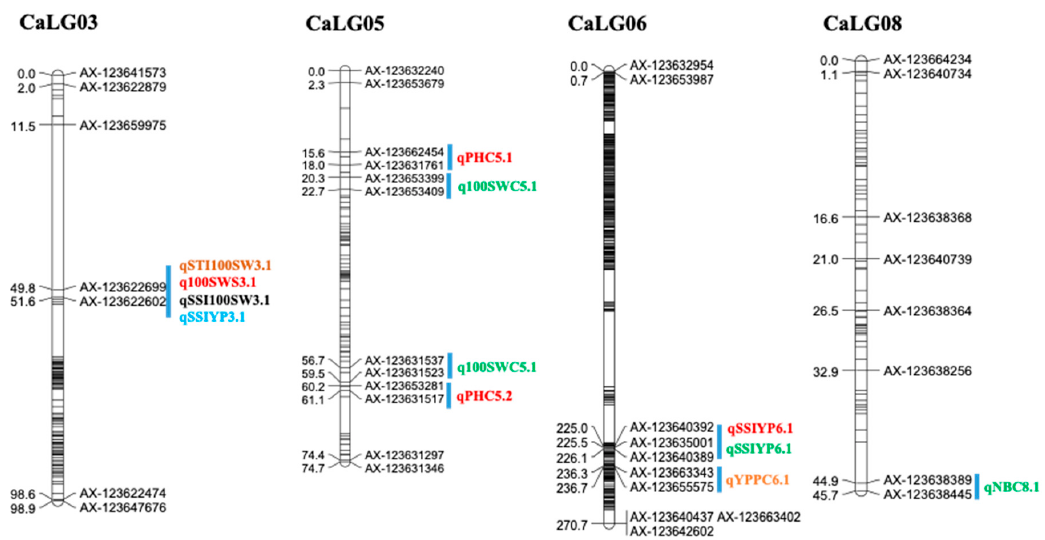
Figure 1. Major quantitative trait loci (QTLs) for various salinity tolerance component traits identified 226 in the DCP 92-3 × ICCV 10 RIL population. 227